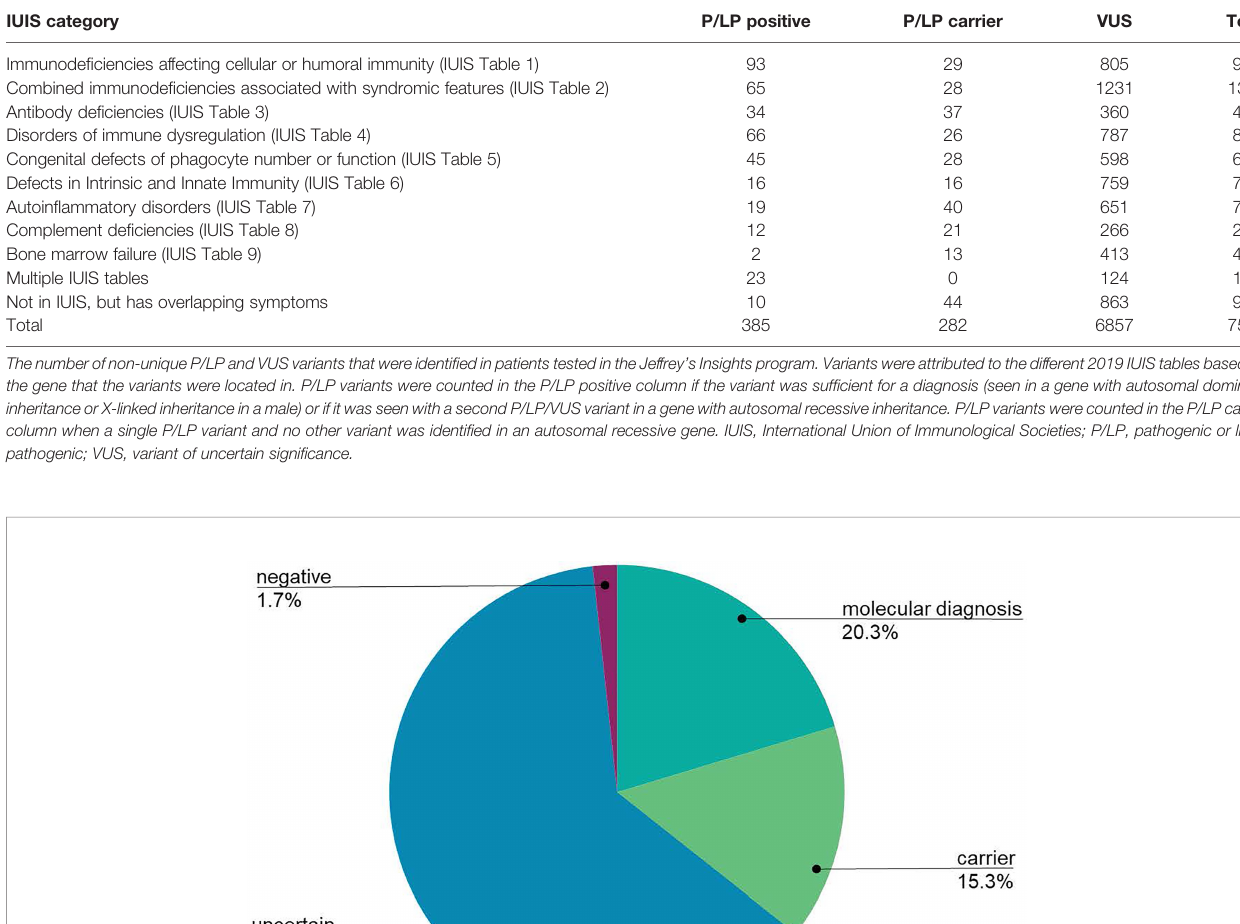
TABLE 2 | Number of non-unique variants identi fi ed by IUIS category.